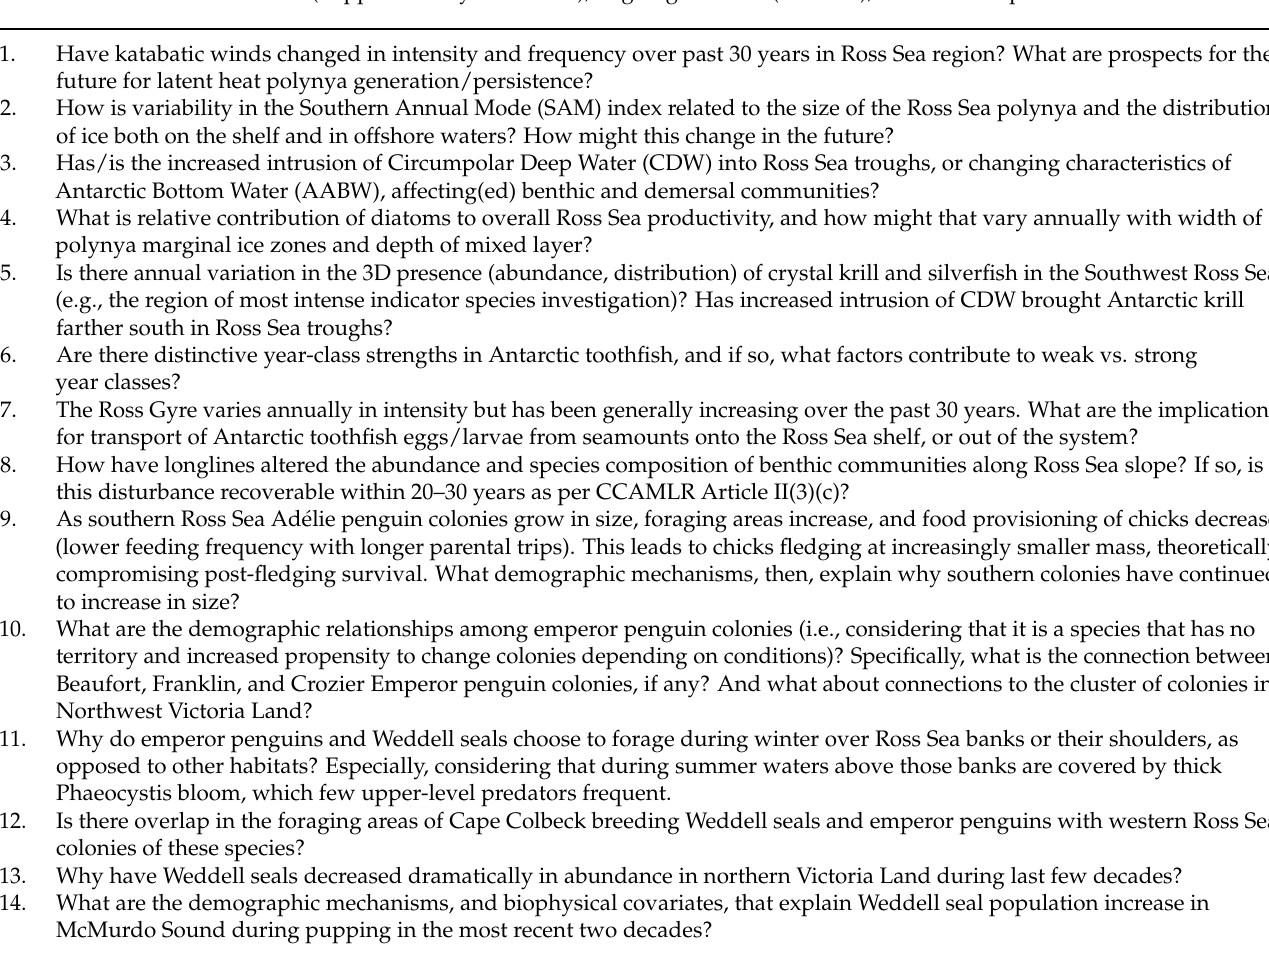
Table 3. Central questions related to understanding, and thus facilitating the protection, of the Ross Sea ecosystem structure and function; most are inter-related. Based on review of literature (Supplementary Material 1), ongoing research (Table S2), and workshop